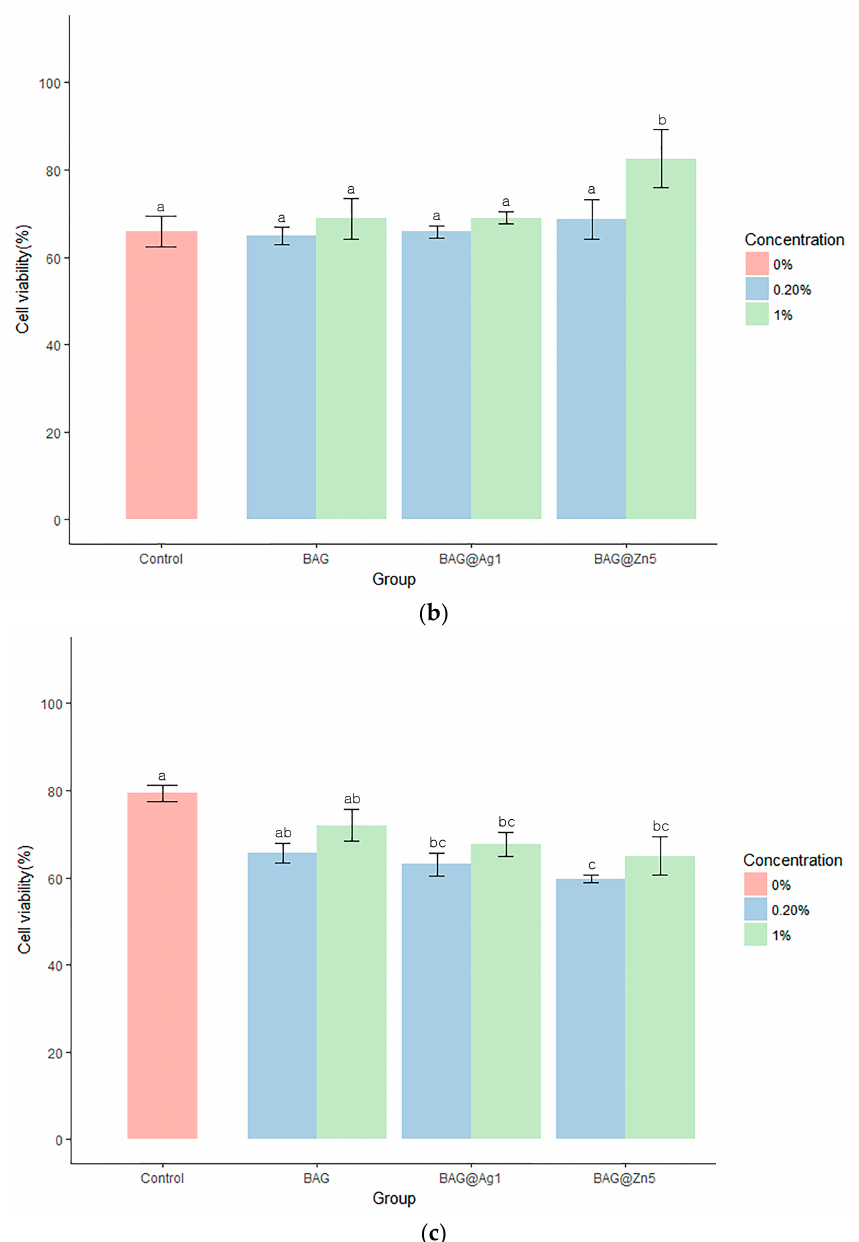
Figure 5. Cell viability test by Human gingival fibroblasts (HGF) cytotoxicity on the cured BAG and ion (silver or zinc)-doped BAG orthodontic bonding primer. ( a ) Cell viability test after 24 h; ( b ) Cell viability test after 48 h; ( c ) Cell viability test after 72 h. Viability is measured using MTT((3-(4,5-Dimethylthiazol-2-yl)-2,5-Diphenyltetrazolium Bromide) absorbance on 620 nm. Duncan’s Multiple Range Test ( n = 3). The same letters indicate that the p -value is not significantly different ( p < 0.05). Error bars indicate the ± standard deviation.